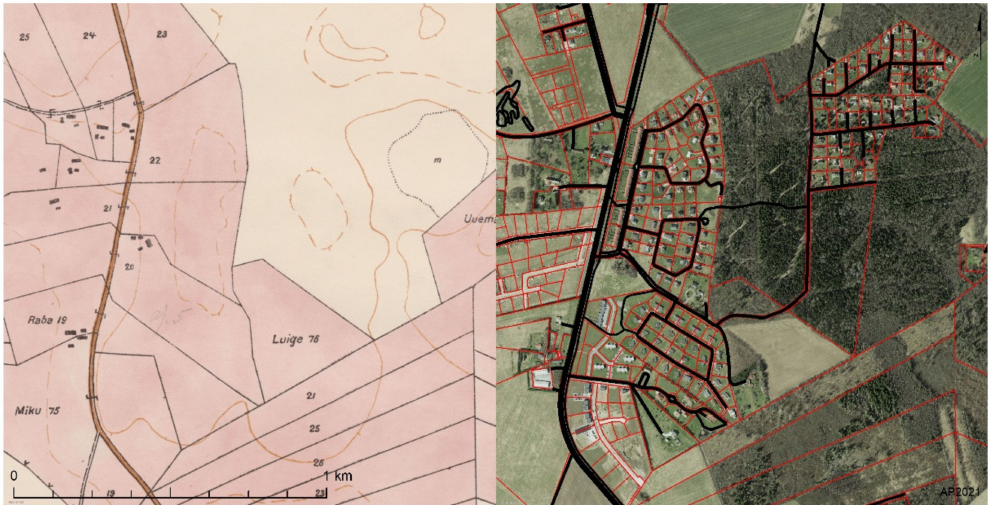
Figure 6. Map of property borders in Vaela village, Kiili municipality, Harju county, near the capital Tallinn (source: Cadastral map of 1930–1944, Cadastral map of 1 January 2021 based on orthophoto from 30 April 2021, overlaid by the road layer from the Estonian Topographic Database 1 January 2021; Estonian Land Board